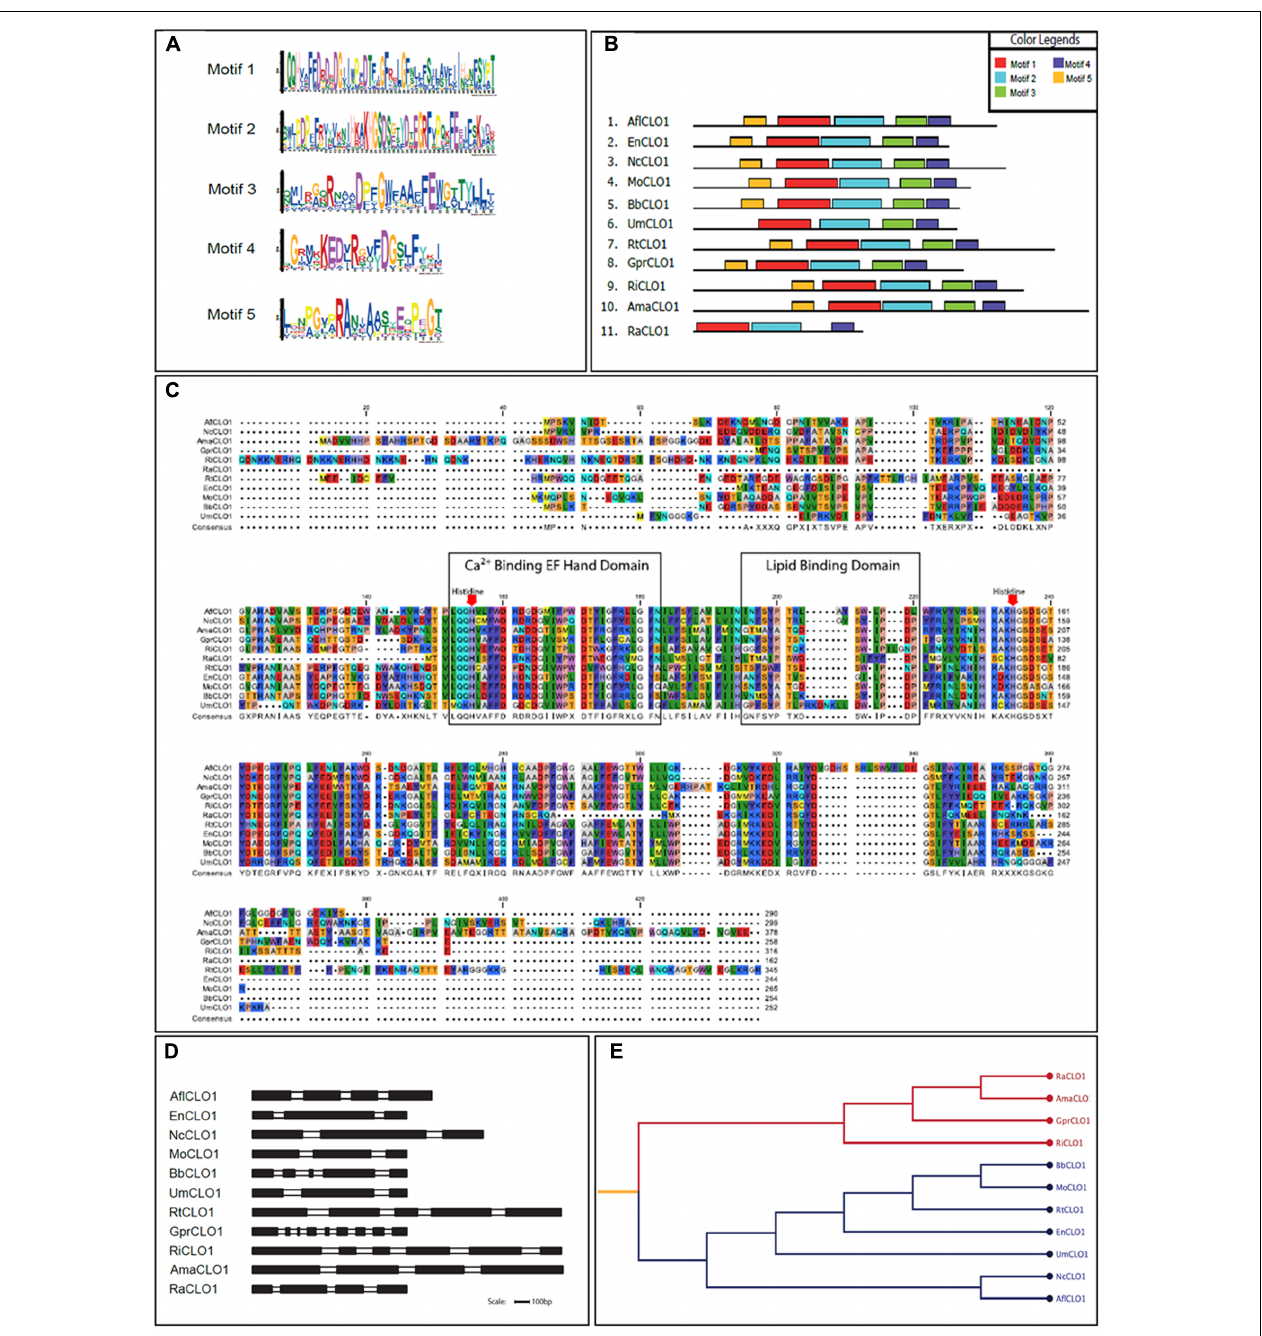
FIGURE 1 | Bioinformatics analysis of caleosin sequences derived from the genomes of A. flavus and other representative fungal species. (A) Motif sequences generated from fungal caleosin protein sequences using http://meme-suite.org/. (B) Block representations of the location on caleosin sequences of the five predicted motifs shown in panel (A) . Each motif is color coded as shown in the upper right box. (C) Amino acid multiple sequence alignment of caleosins from selected fungal species. Multiple alignments were performed using Clustal Omega (ClustalO) from https://www.ebi.ac.uk/Tools/msa/clustalo/. The CLC sequence viewer from CLCBio was used to inspect the alignments. Caleosins were obtained from the NCBI database (http://www.ncbi.nlm.nih.gov) under accession numbers presented in Supplementary Table S4. Domain properties of the proteins were analyzed using the UniProt platform (http://www.uniprot.org). Color coding is as follows: the multiple sequence alignment residues are colored according to Rasmol amino color scheme, first boxed residues indicate the combined Ca 2 + binding EF hand domain and second boxed residues indicate the lipid binding domain. The invariant heme-binding histidine motif is marked in red with down arrows. (D) Intron/exon structures of selected fungal caleosin genes generated using WebScipio. Exons are depicted as solid bars while introns are clear bars. Scale bar is 100 bp. (E) Phylogenetic tree to represent the cladistic relationship between A. flavus and other representative fungal species. Sequences from the more advanced Dikarya species, including A. flavus , are shown in blue and sequences from the more basal and divergent taxa are shown in red.